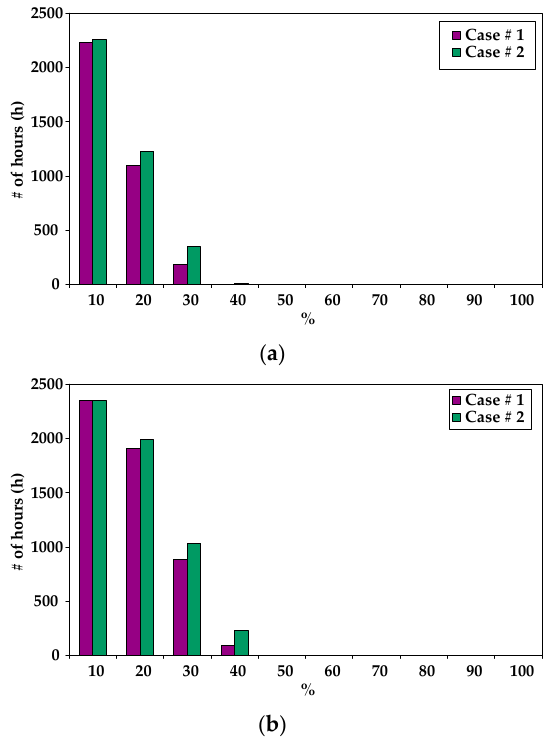
Figure 6. Percentage of occupants dissatisfied with the indoor environment: ( a ) female, light clothes, moderate workload; ( b ) male, light clothes, moderate workload.